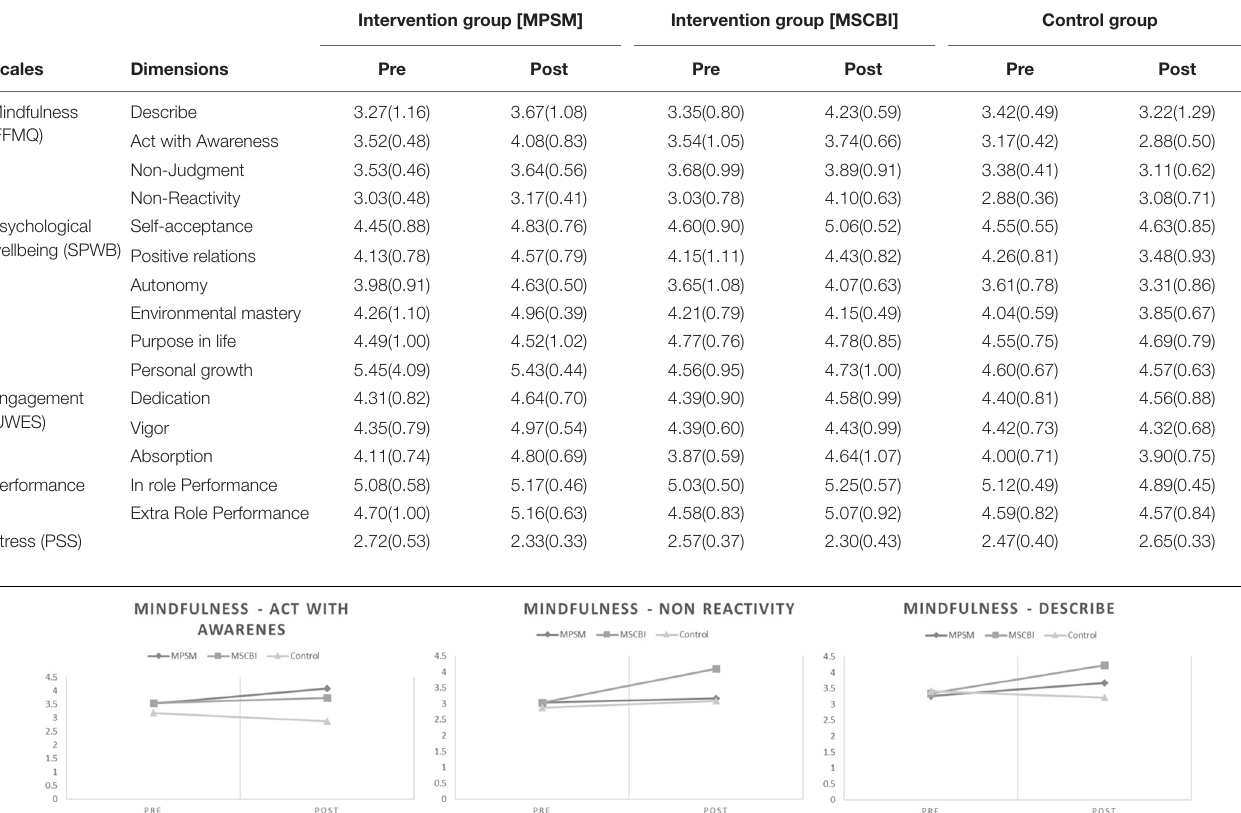
TABLE 7 | Pre – Post-intervention and control groups scores– mean (SD).